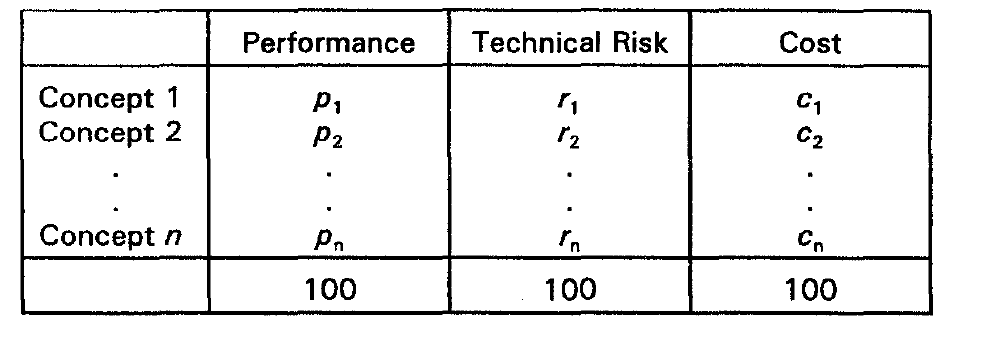
Table 1: Normalised